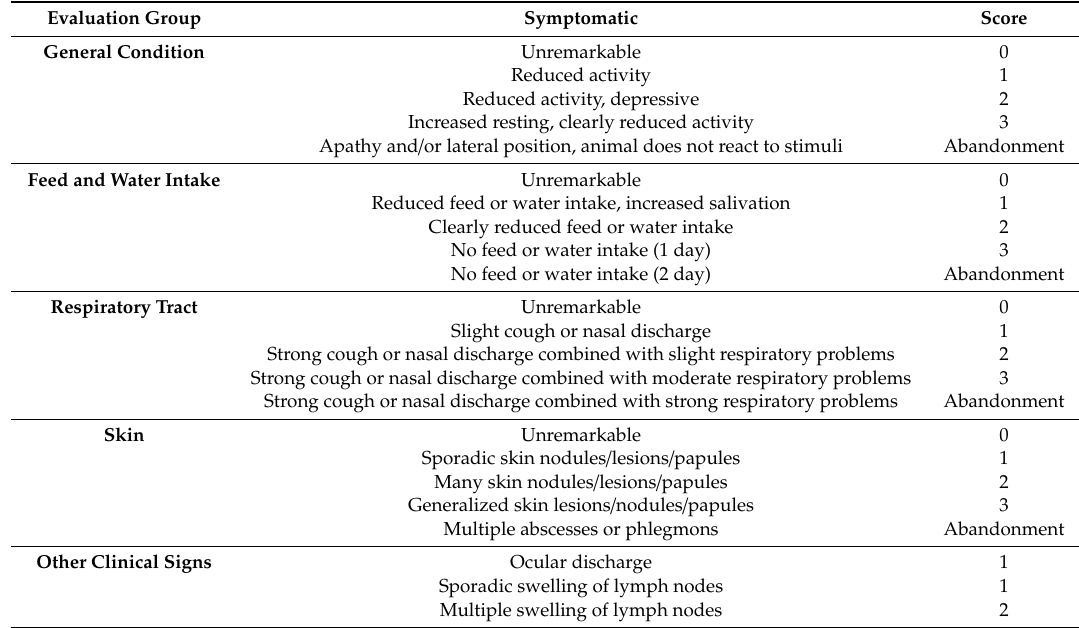
Table 1. Clinical reaction score system used during the described animal